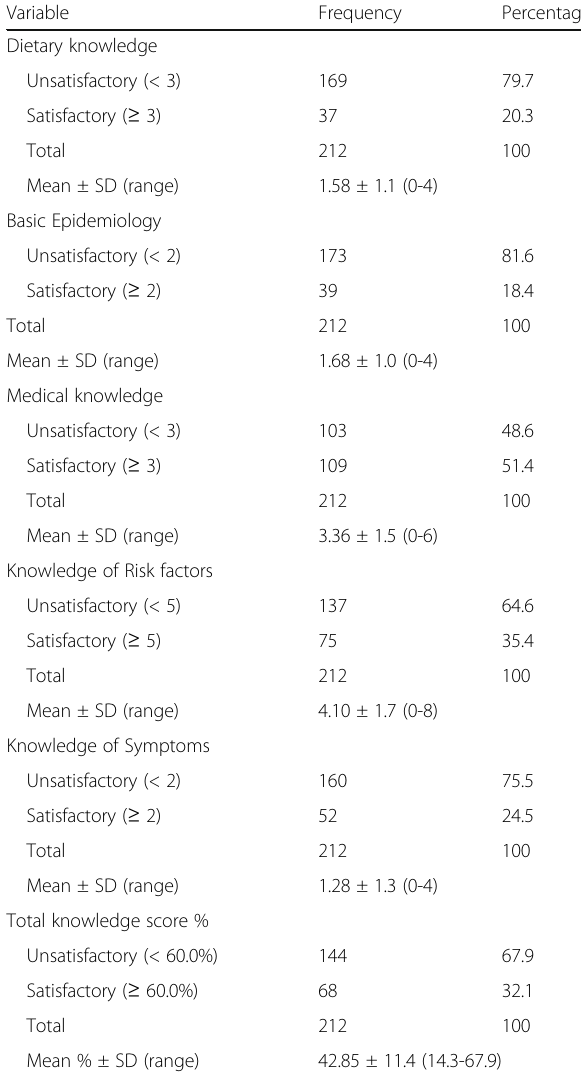
Table 4 Distribution of sub-scores for knowledge of CVD ( N = 212)